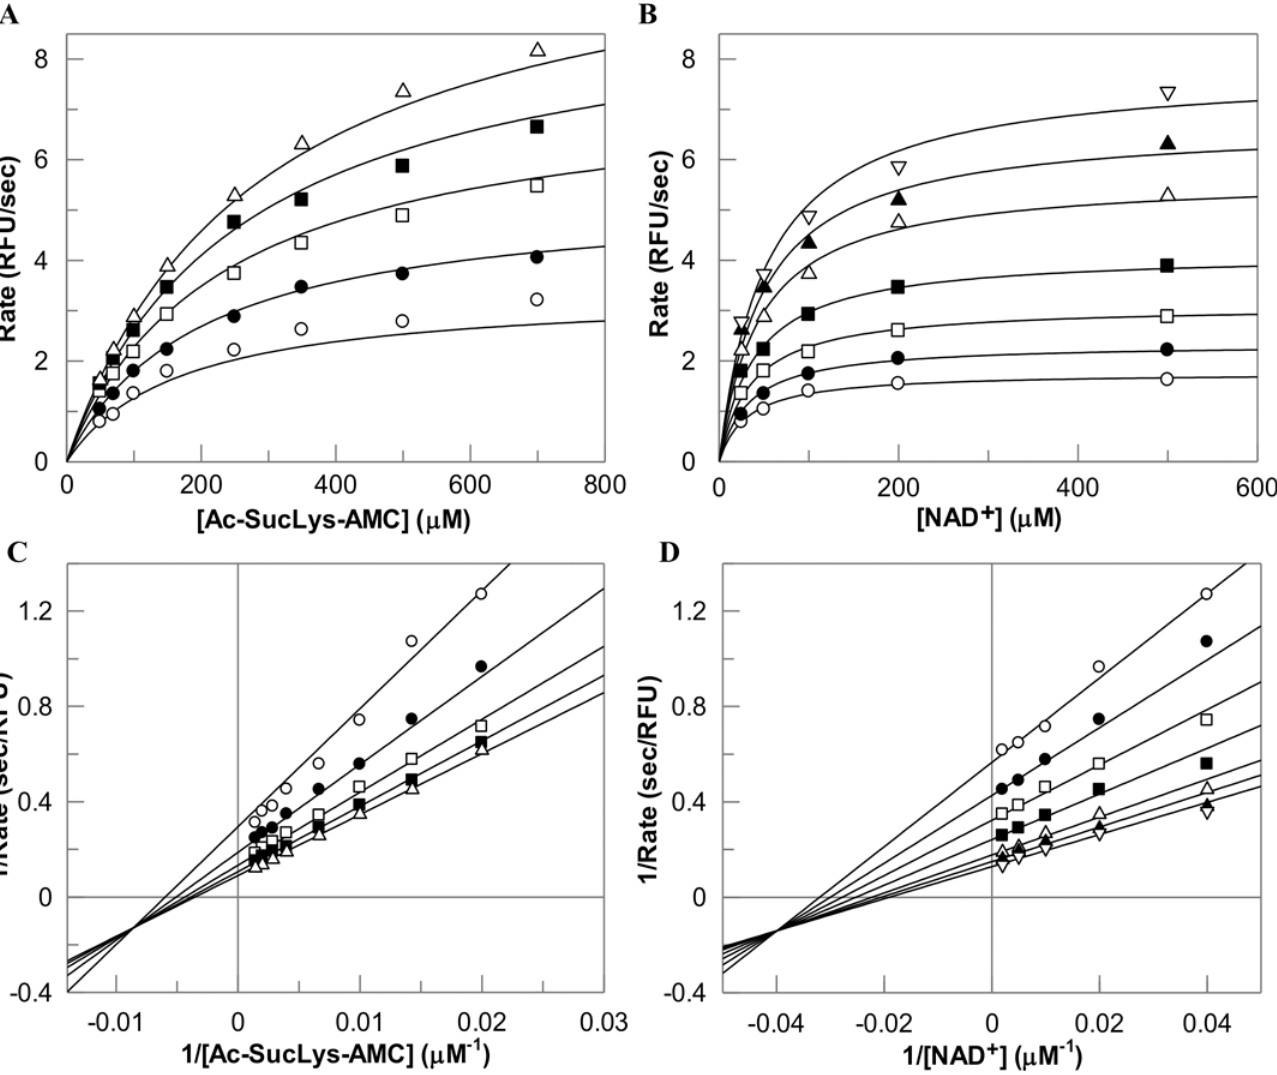
Fig 6. Two Substrates Reactions of SIRT5. The two substrate SIRT5 catalyzed reaction was performed under the steady-state condition with varying concentrations of Ac-SucLys-AMC substrate (25, 50, 100, 200, and 500 μ M) and NAD + (50, 70, 100, 150, 250, 350, 500, and 700 μ M). The data were fitted to the bi-substrate ternary complex kinetic mechanism for the binding of the substrate followed by the binding of NAD + by Eq 4 using Grafit software. The initial rates of SIRT5 catalysis as a function of increasing concentration of Ac-SucLys-AMC substrate at changing fixed concentrations of NAD + (A), and as a function of increasing concentration of NAD + at changing fixed concentrations of Ac-SucLys-AMC substrate (B) The double-reciprocal plot of 1/ v vs 1/[NAD + ] at increasing concentration of Ac-Suclys-AMC substrate (C), and the double-reciprocal plot of 1/ v vs 1/[Ac-Suclys-AMC] at increasing concentration of NAD + (D) are also